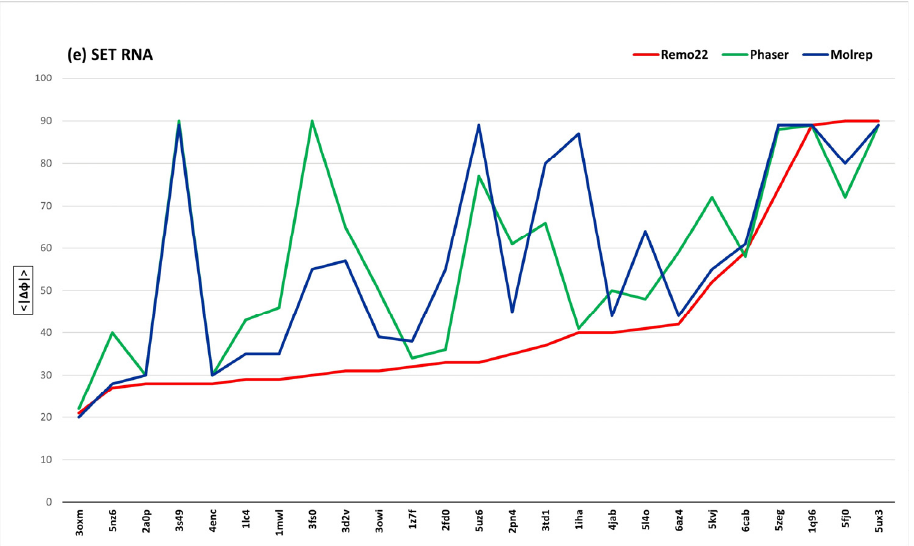
Figure 1. The average phase errors <| Δϕ |> (in degrees) obtained by REMO22 (<| Δϕ |> R ; red line), PHASER (<| Δϕ |> P ; green line) and MOLREP (<| Δϕ |> M ; blue line) at the end of the MR steps (( a ) SET PH; ( b ) SET PD; ( c ) SET PG; ( d ) SET DNA; ( e ) SET RNA). In cases where an MR program declares a failure before the standard ending, we assume <| Δϕ |> = 90° (in five DNA-RNA cases for PHASER). The structures are ordered in increasing values of (<| Δϕ |> R ) for clarity. Table 3. The results for each pipeline segment are quoted: (i) the global average phase error (cid:104)| ∆ φ |(cid:105) MR calculated over all the test structures at the end of the MR step via REMO22, PHASER and MOLREP, and the corresponding (cid:104)| ∆ φ |(cid:105) calculated after the phase refinement step using either SYNERGY REF or RESOLVE. All phase errors are in degrees; (ii) the number of proteins for which SYNERGY or RESOLVE improves the MR average phase error by at least 10 ◦ (N P 10) and by at least 20 ◦ (N P 20); (iii) the number of nucleic acids for which SYNERGY or RESOLVE improves the MR average phase error by at least 10 ◦ (N NA 10) and by at least 20 ◦ (N NA 20). Pipeline Segment ⟨|𝚫𝛟|⟩ 𝐌𝐑 ⟨|𝚫𝛟|⟩ 𝐑𝐄𝐅 N P 10 N P 20 N NA 10 N NA 20 REMO22 + SYNERGY 45 41 12 0 0 PHASER + SYNERGY 58 MOLREP + SYNERGY 56 10 PHASER + RESOLVE 58 0 MOLREP + RESOLVE 56 54 1 0 1 0